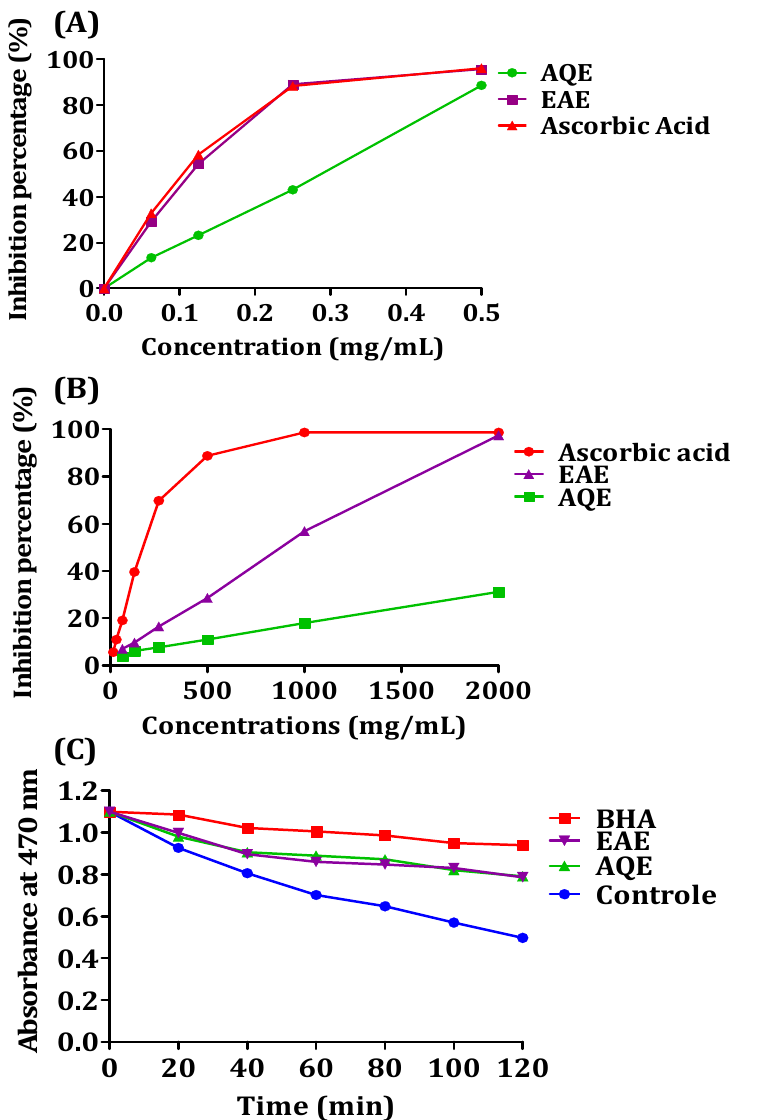
Figure 4. The activity of the scavenging DPPH radical, ( A ) iron reduction, ( B ) and bleaching kinetics of β -carotene, ( C ) in the presence and absence of EAE, AQE, and reference. EAQ—ethyl acetate extract; AQE—aqueous